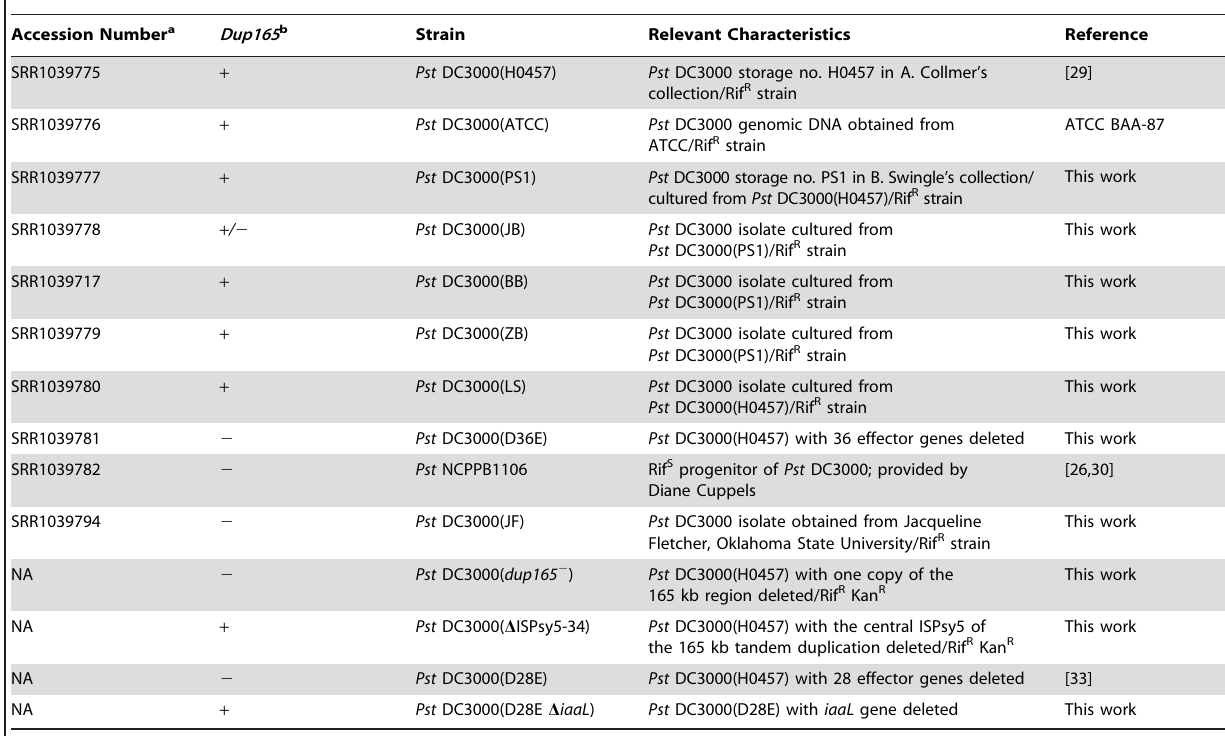
Table 1. P. syringae pv. tomato strains used in this